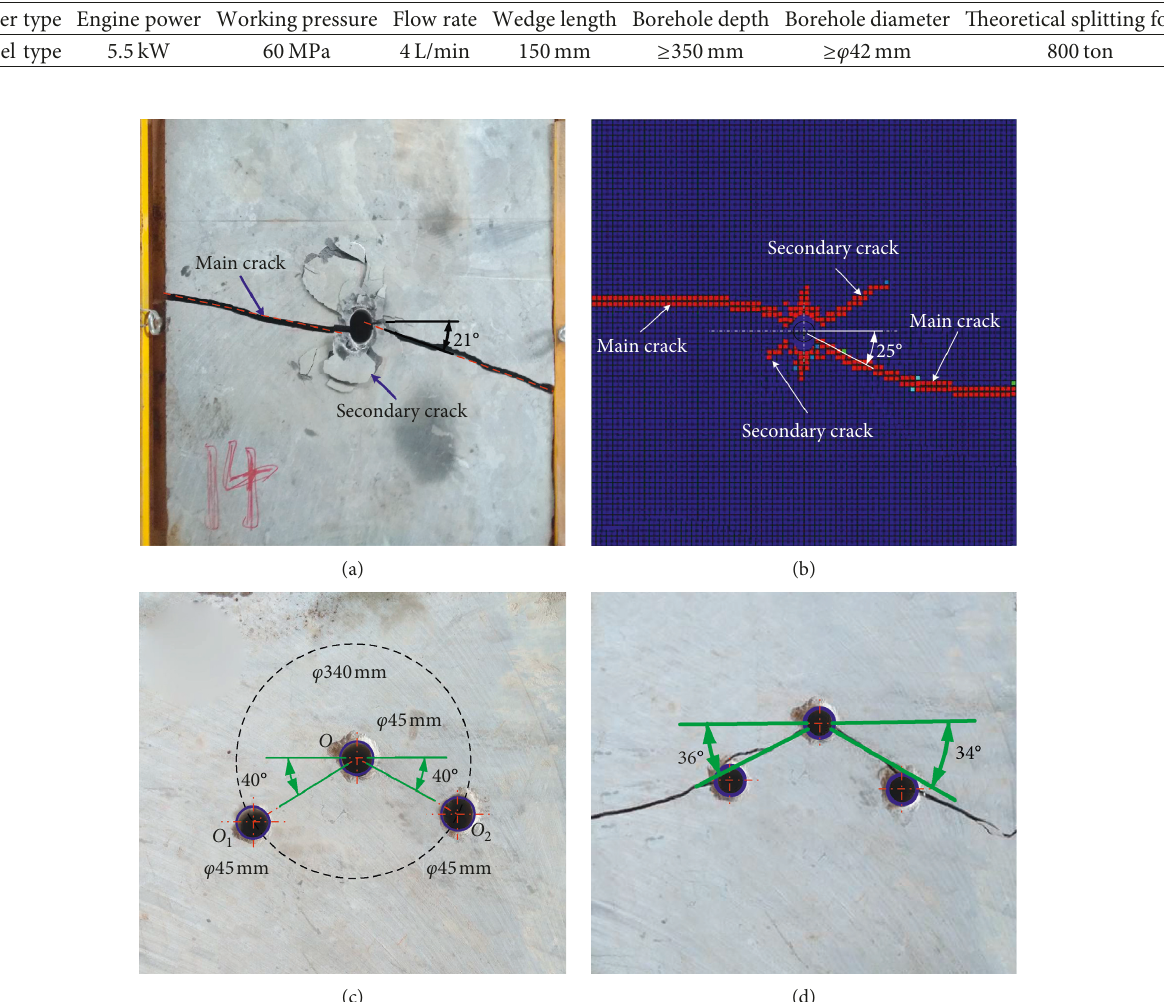
Figure 11: Rock-breaking state with nonauxiliary holes for (a) experiments and (b) simulation; (c) parameters of hole-assisted rock breaking; (d) experimental rock-breaking state with auxiliary hole.